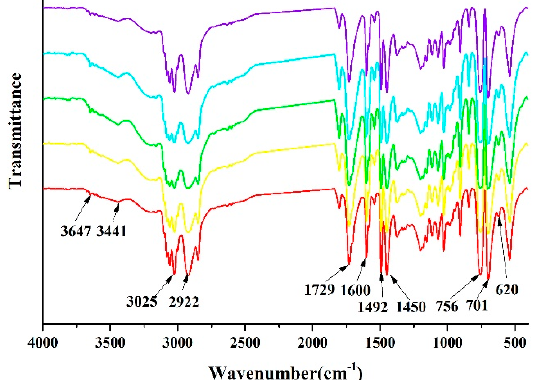
Figure 7. Fourier transform infrared spectroscopic (FTIR) spectroscopic analysis of colloidal crystal coatings prepared from spheres of different diameters.